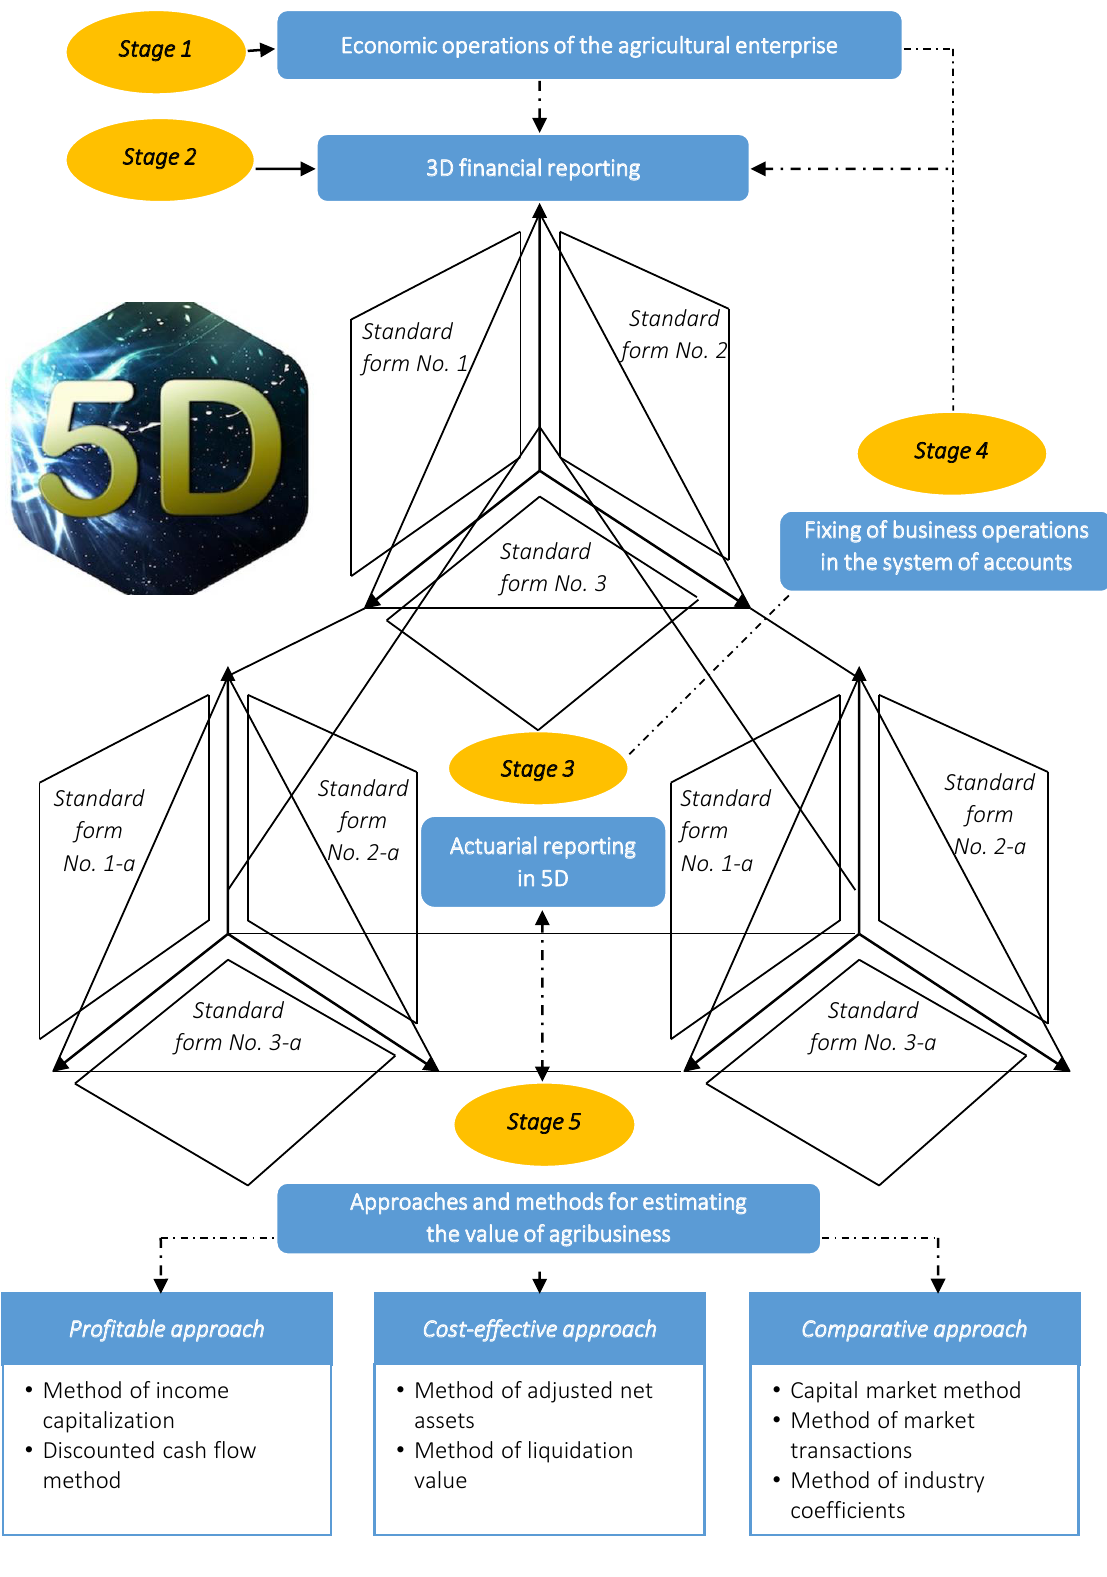
Figure 1. Innovative 5D model of agribusiness